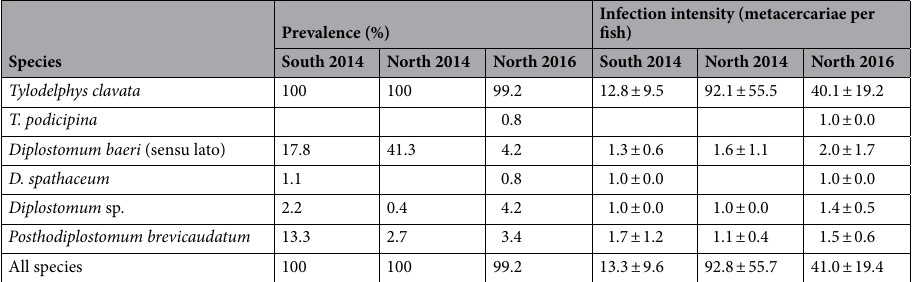
Table 1. Prevalence and mean intensity ± S.D. of trematodes infecting the eyes of YOY perch ( Perca fluviatilis ) from two sampling sites (“South” and “North”) of Lake Müggelsee in 2014 and